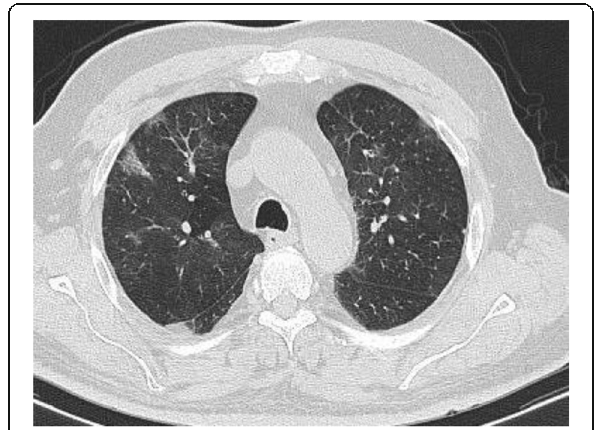
Fig. 22 Pleural thickening in the right side in patient with COVID-19 pneumonia